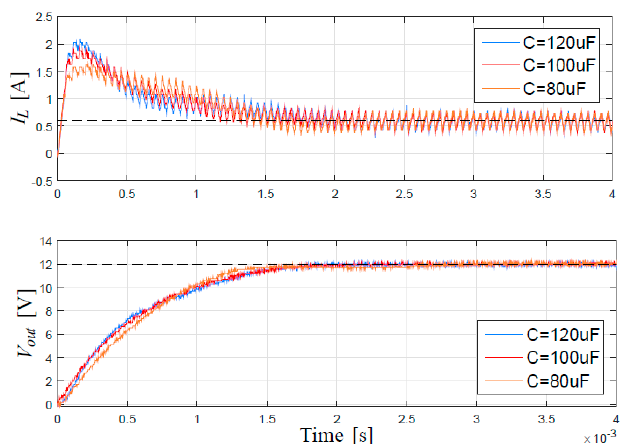
Figure 16. Step responses with the proposed design procedure when the model value of the capacitor is 100 μ F − 20%, 100 μ F+20%.